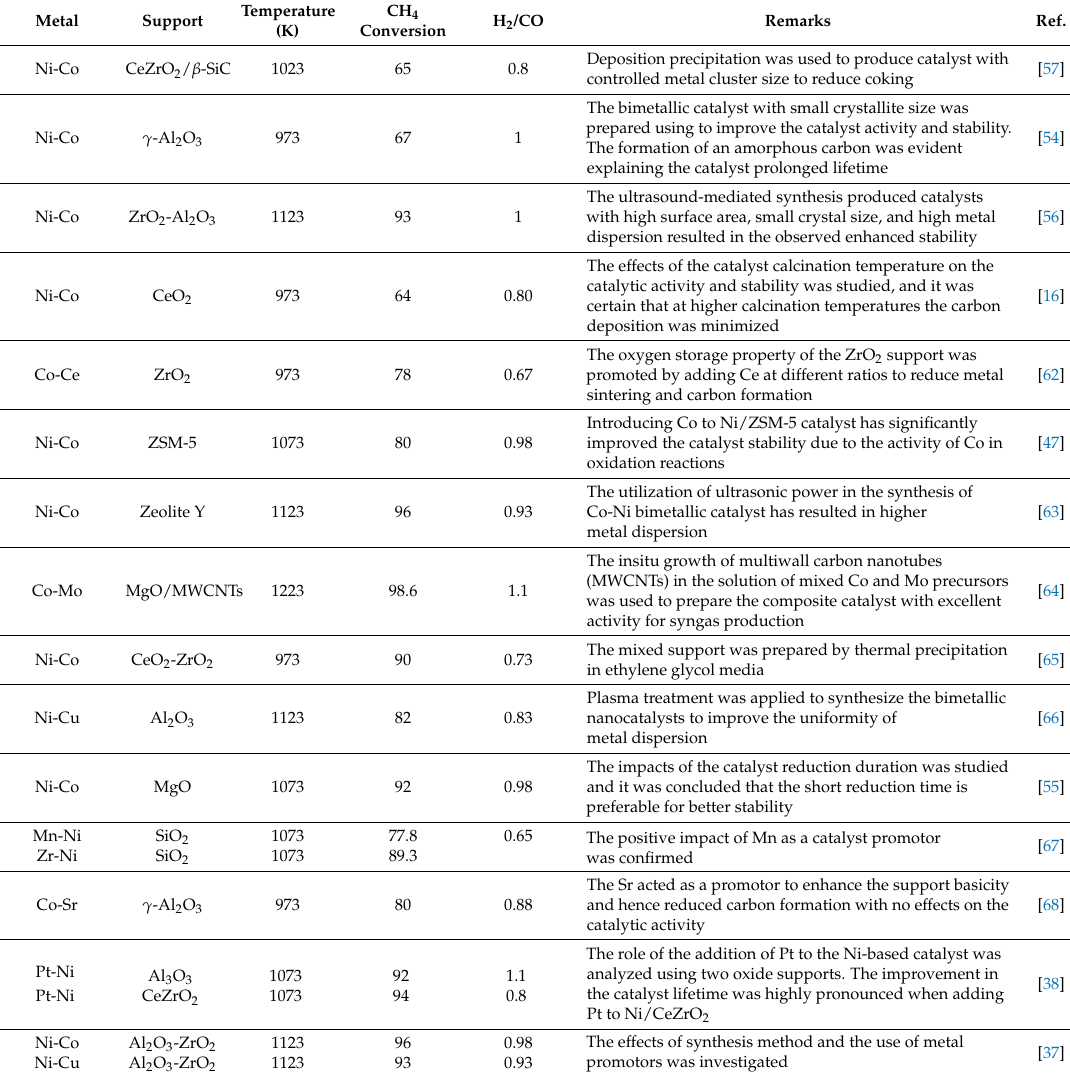
Table 3. Bimetallic catalyst systems for